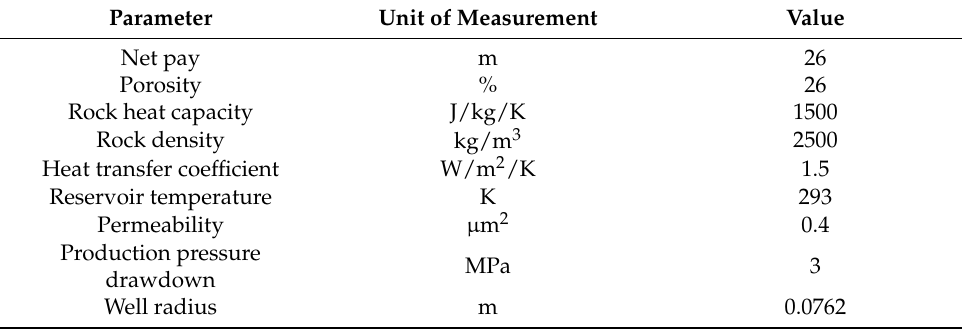
Table 1. Input data for numerical simulation by reservoir parameters.